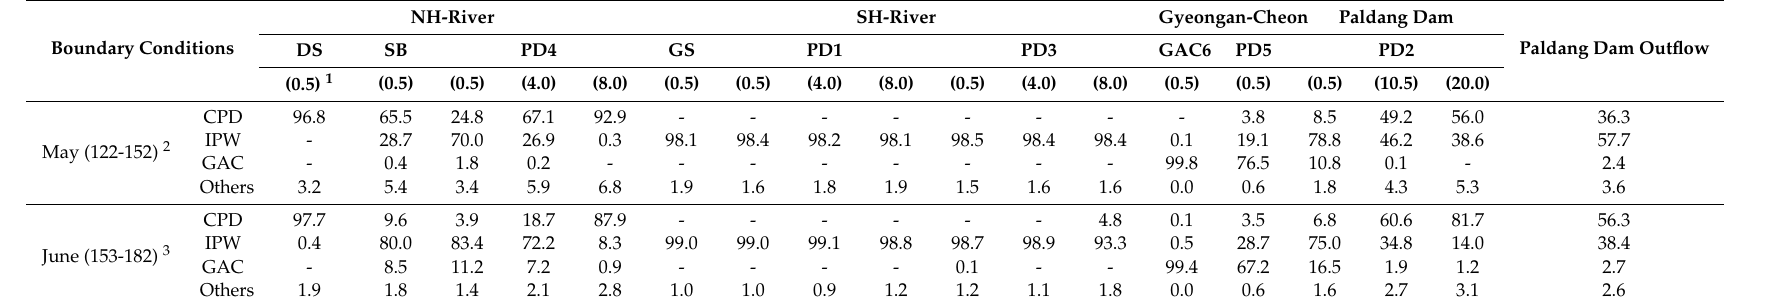
Table 4. Contributions of each inflow boundary condition at each monitoring point (unit: